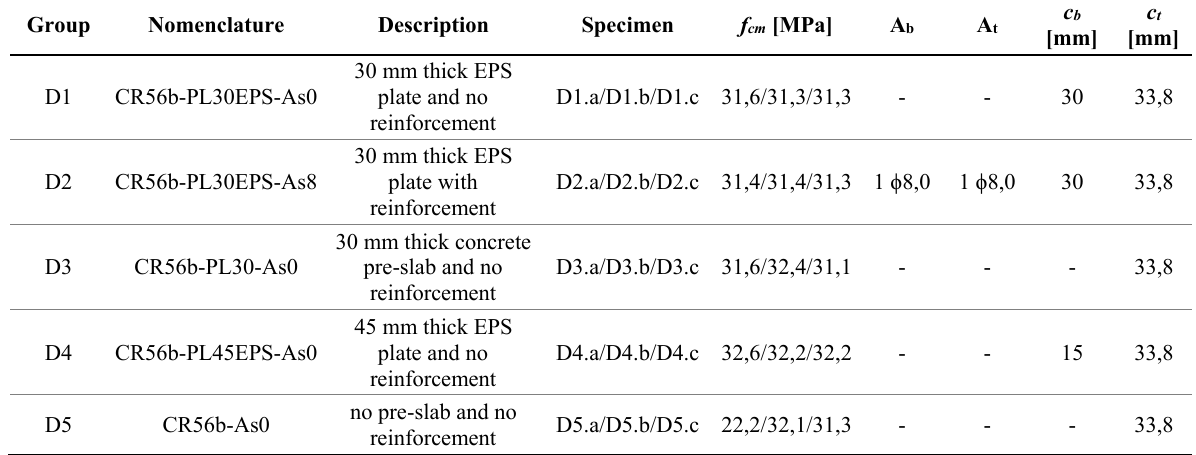
Table 1. Parameters and description of